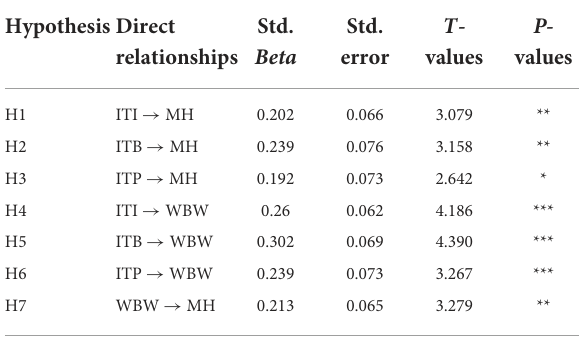
TABLE 4 Results of direct effects. TABLE 5 Results of mediation